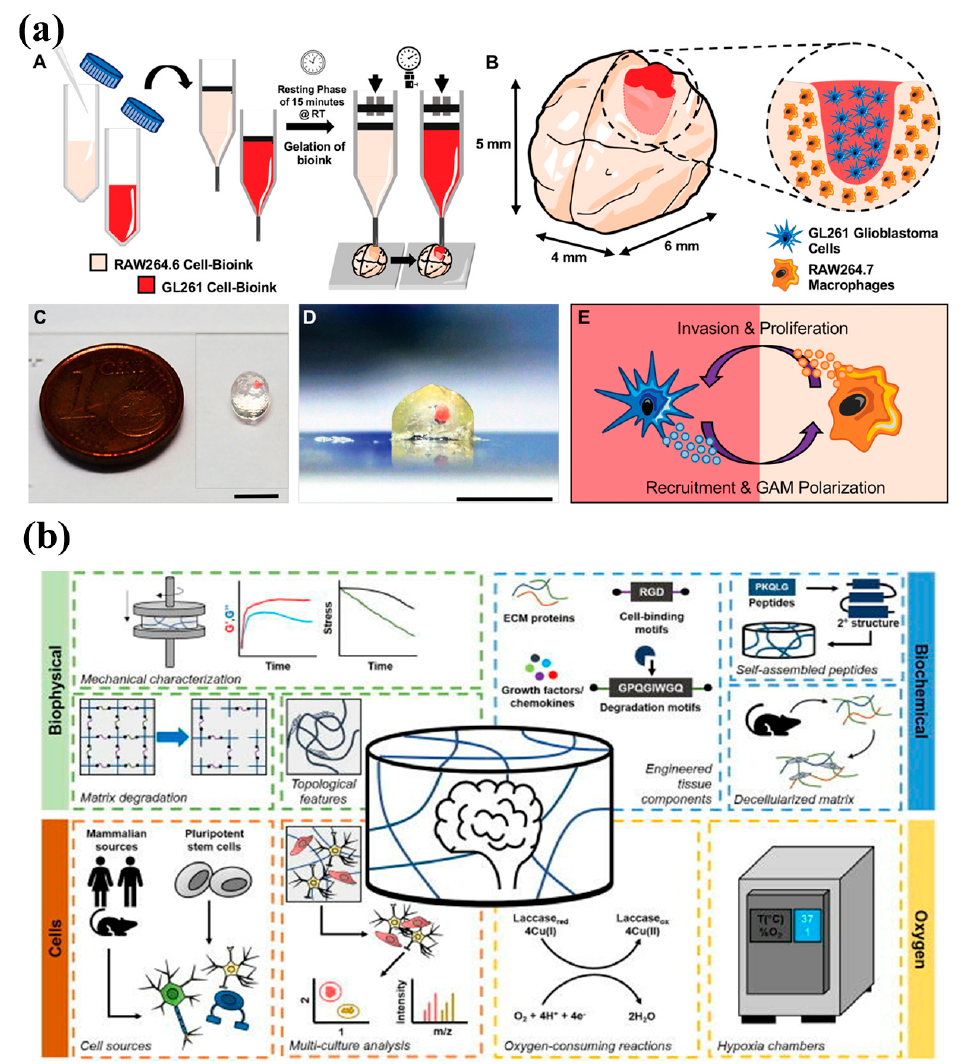
Figure 10. ( a ) Schematic representation of the bioprinting process and the bioprinted mini-brain (A) Preparation and two-step bioprinting of the mini-brains. (B) Close-up and cross-sectional view of the bioprinted mini brains. (C) Glioblastoma area in red. (D) Cross-section in the frontal plain (E) Schematic of interaction between glioblastoma cells and macrophages (adapted with permission from [351] Wiley, 2019) ( b ) Components of engineered brain-mimetic platforms involving biophys- ical parameters, oxygen content, biochemical and cellular composition (adapted with permission from [352] AIP, 2021).